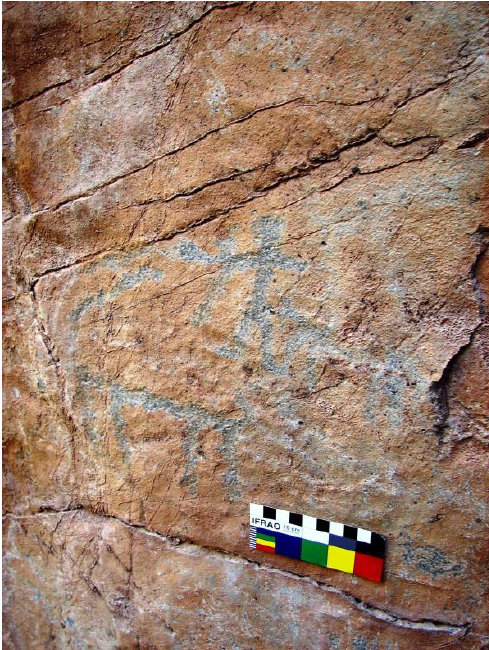
Figure 3. A possible hunting scene showing zoomorphs and an anthropomorph with “bow and